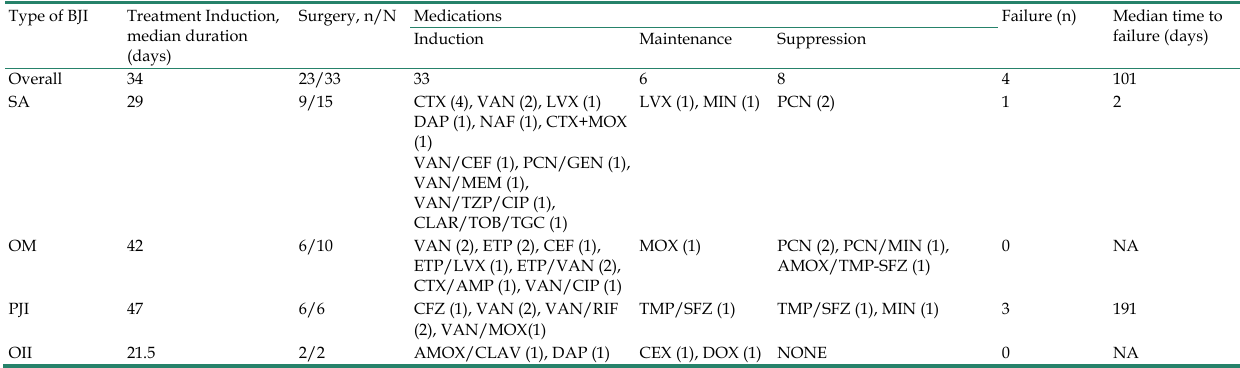
Table 3: Description of Treatment Type of